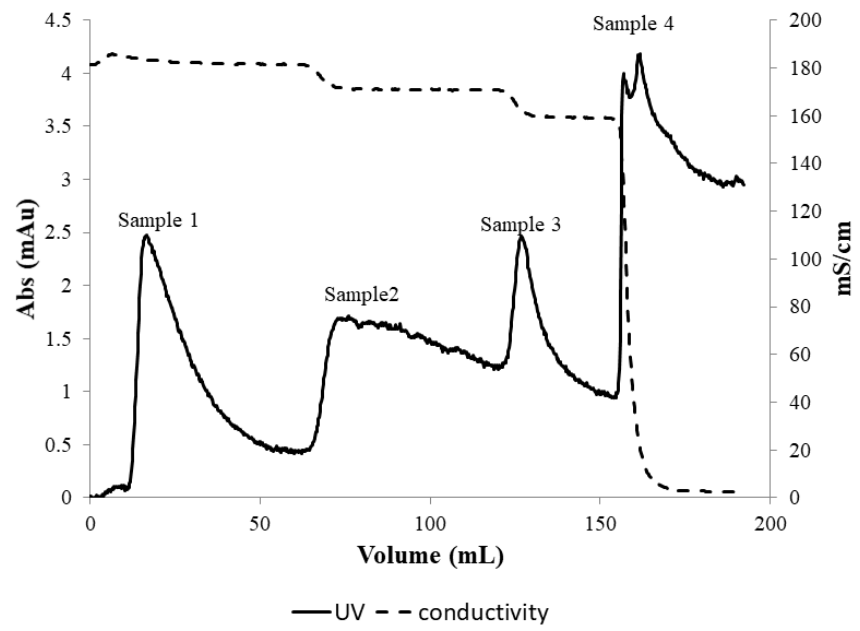
Figure 5. Hybrid separation of PEG-HSA using stirred cell membrane module. Samples 1 – 4 correspond to the 1.65, 1.5, 1.35, and 0 M ammonium sulfate concentration in the stirred cell membrane module.